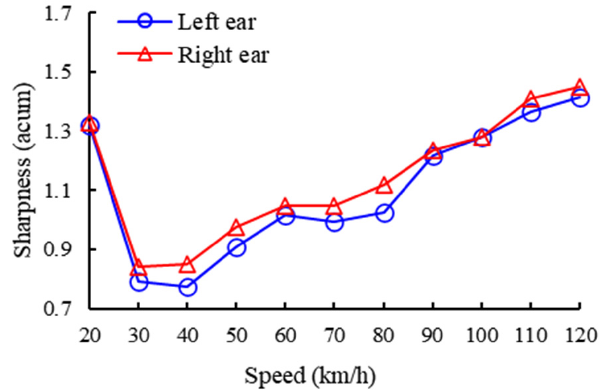
Figure 7. Interior noise sharpness in the EV as a function of the vehicle’s speed.